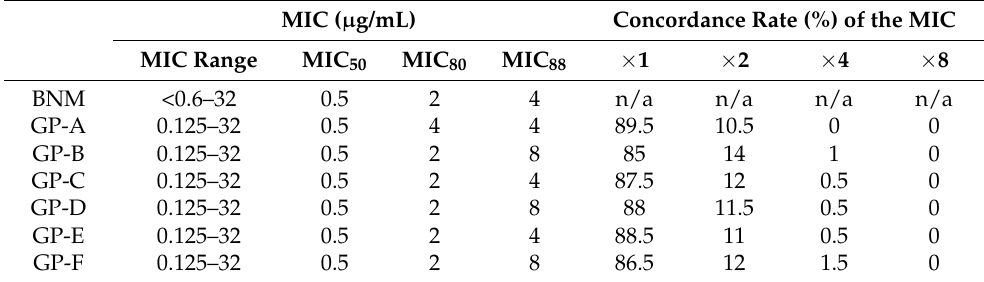
Table 1. Antimicrobial susceptibility in vitro. MIC ( µ g/mL) and concordance rate (%) of each GP’s MIC to BNM against clinical isolates of P. aeruginosa